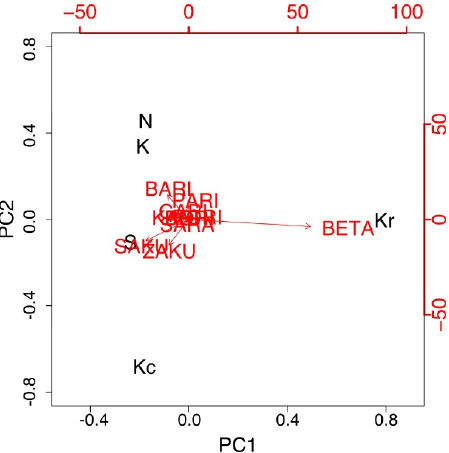
Figure 8. PCA biplots of the cumulative dominance duration of each mimetic word in Experiment 2. The variance of PC1 and PC2 had a contribution of 86% and 12%, respectively. Samples S, K, and N are available commercially and produced by different manufactures. Sample Kr was a moisturized and re-dried version of K, and Kc was a crushed version of K. PCA, principal component analysis. As in Experiment 1, liking scores for all the samples decreased with time (Figure 9a). A one-way repeated measures ANOVA was performed for the averaged liking scores over time and revealed a significant main effect of the sample [ F (4, 76) = 72.04, p < 0.05, η p2 = 0.79] (Figure 9b). A post-hoc multiple comparison test (Tukey’s test) revealed that the liking score for Kr was significantly lower than that for the remaining four samples ( p s < 0.05), and the liking score for N was significantly lower than that of S ( p < 0.05).